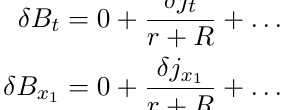
Figure 5 . Plots of the real and imaginary part of the gap as function of the source ρ dashed black lines corresponds to the analytic prediction. Here { T, c, λ, φ and k = 10 − 4